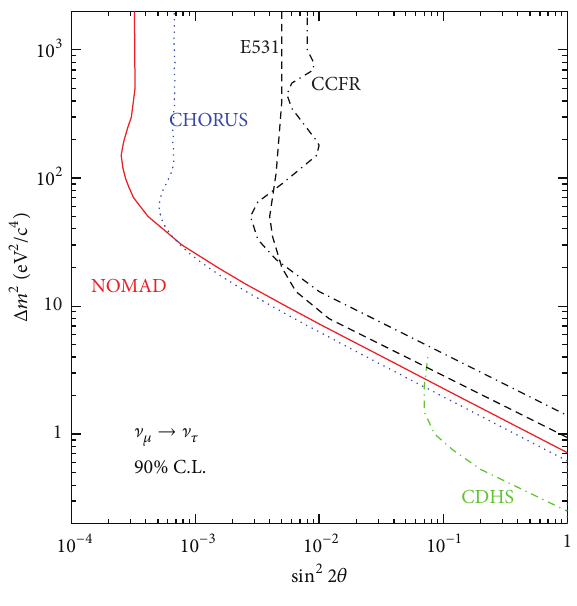
Figure 10: Final exclusion plot in the plane (sin 2 2 𝜃 𝜇𝜏 - Δ𝑚 2 ) for the channel ] 𝜇 → ] 𝜏